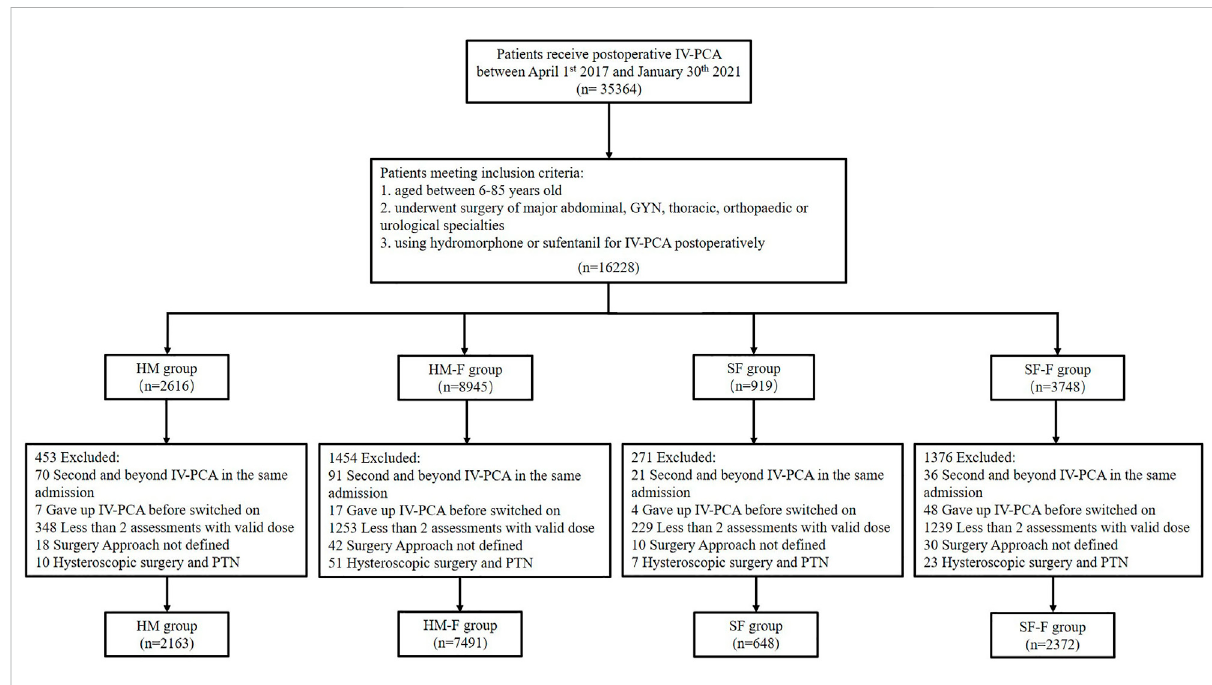
FIGURE 1 Flow chart showing the study organization, including patient inclusion, exclusion, and classi fi